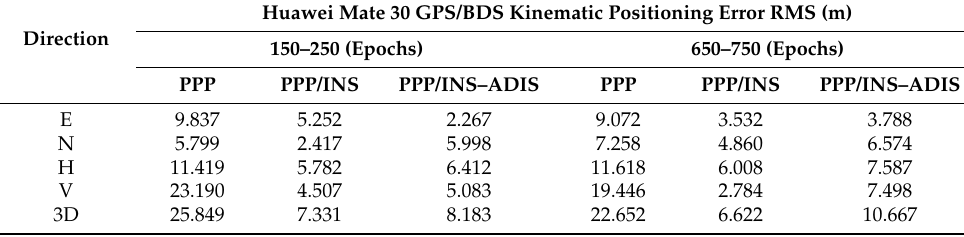
Table 4. The RMS of PPP, PPP/INS, and PPP/INS positioning errors using Huawei Mate 30 on the areas marked by purple boxes 1 and